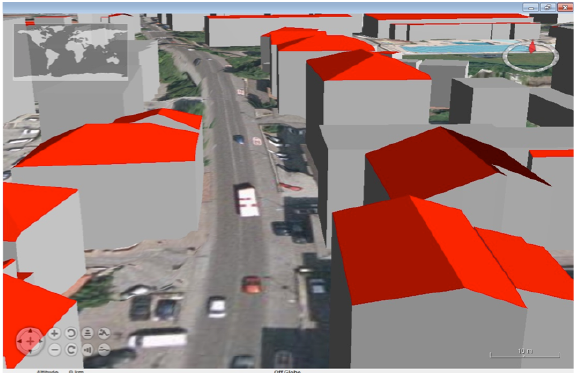
Figure 1: CityGML LoD2 automatically generated by novaFactory platform starting from buildings footprint and